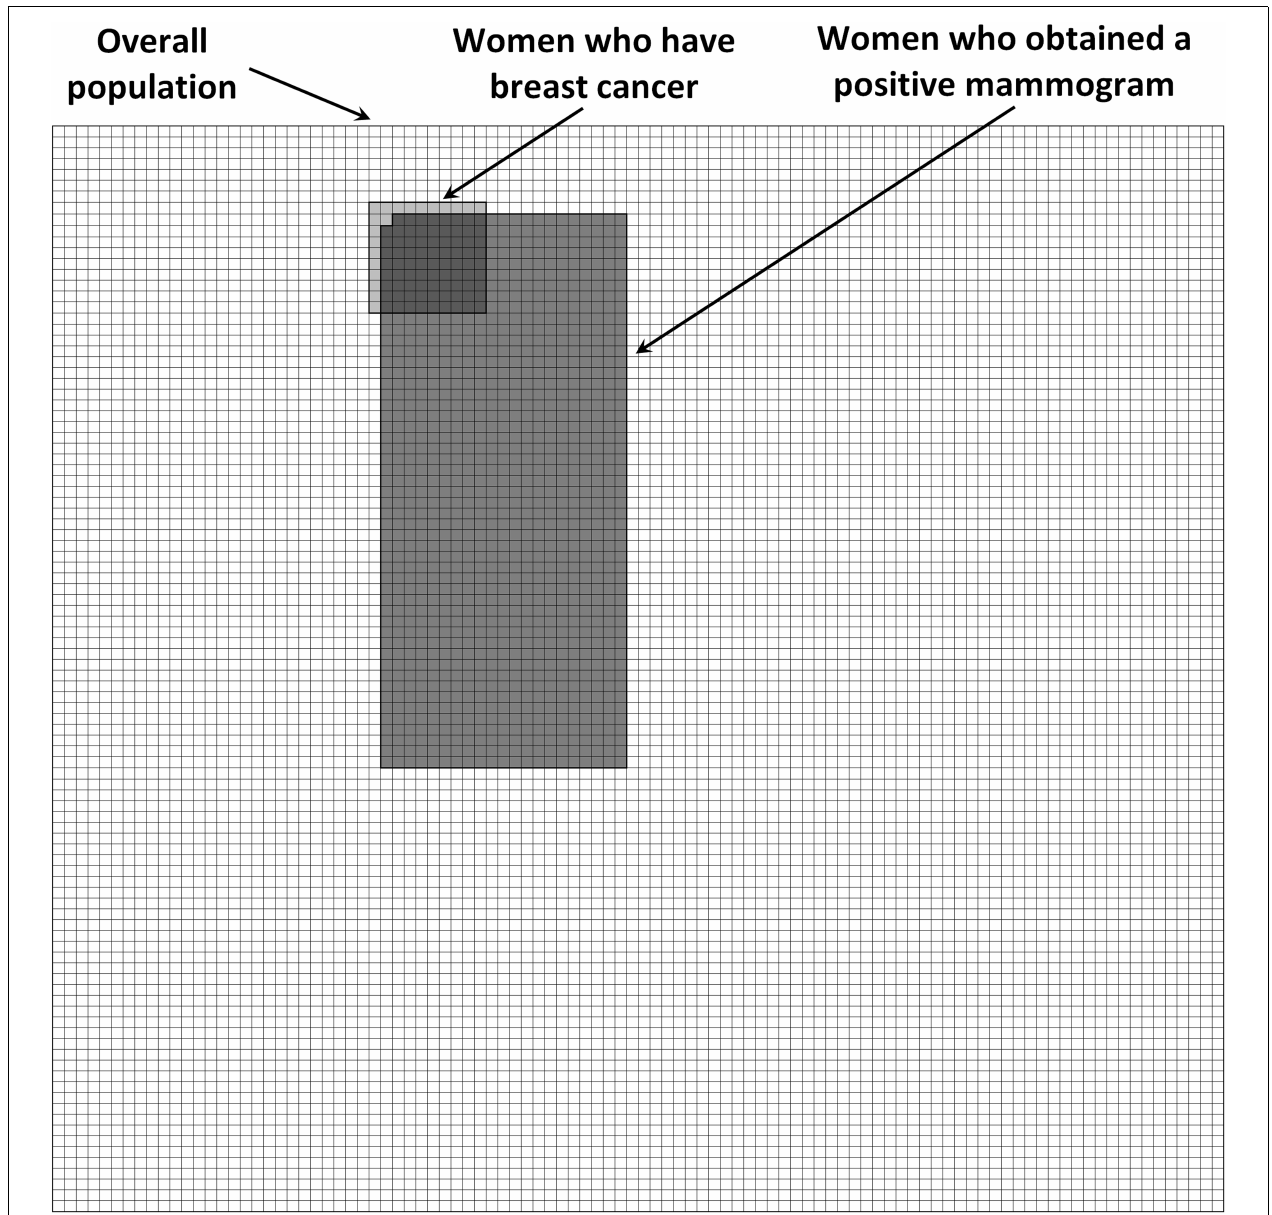
FIGURE 1 | Visual aid representing the overall number of women at risk, the number of women who have breast cancer, and the number of women who obtained a positive mammogram.